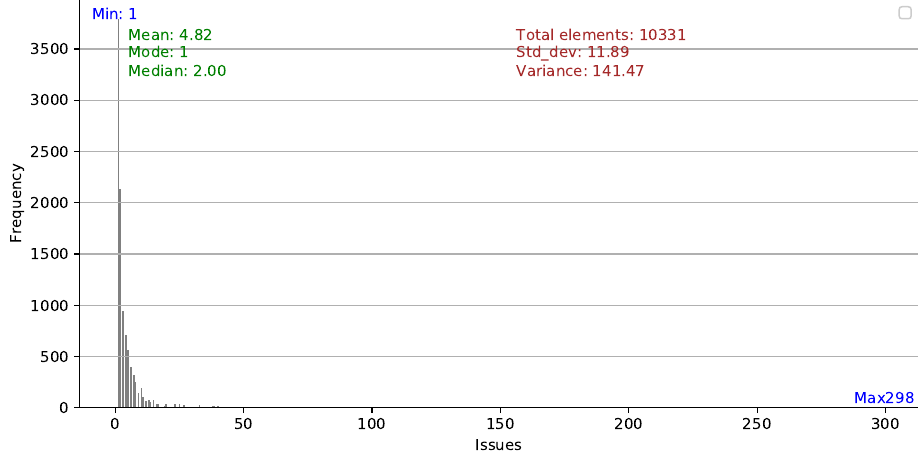
Figure 4. Reports of most extended overflows and analysis of issues per